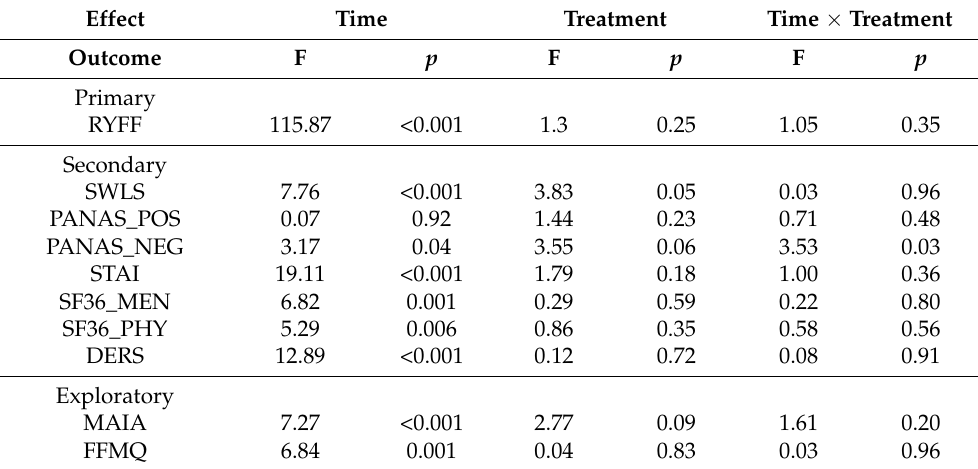
Table 2. Main and interaction effects for overall outcomes in overall analysis (Repeated Measures